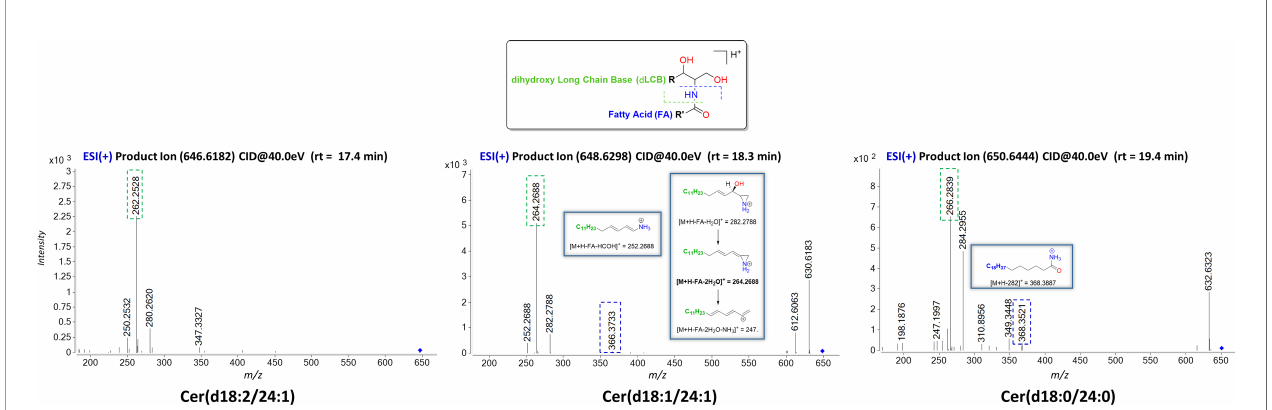
green dashed square, and fragment ions possessing an FA chain structure are framed in a blue dashed square. Proposed structures for main ion fragments observed based on published predictions (47).